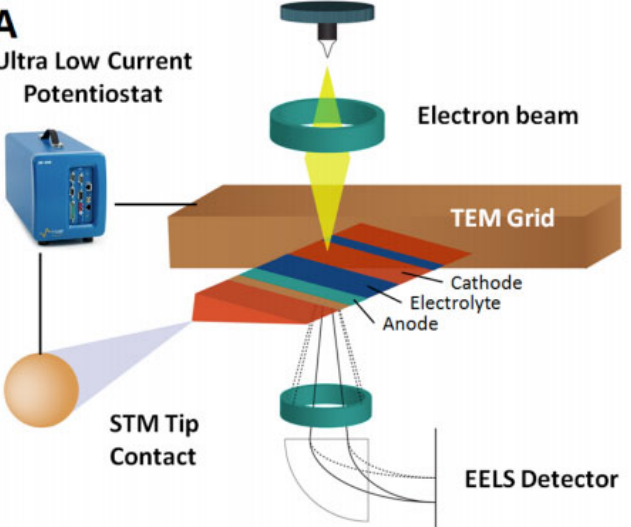
Figure 5. Schematic of in situ TEM biasing of nanobattery. Reprinted with permission from ref. [53]. Copyright 2016 American Chemical Society Publications.